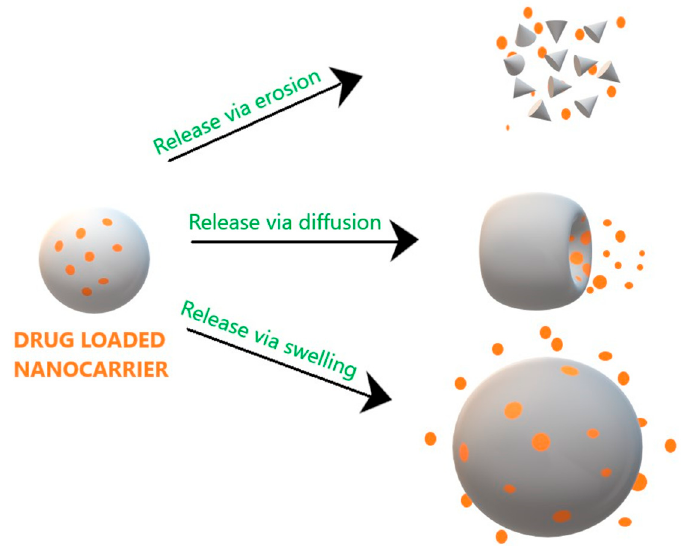
Figure 4. Drug release mechanism from chitosan NPs.